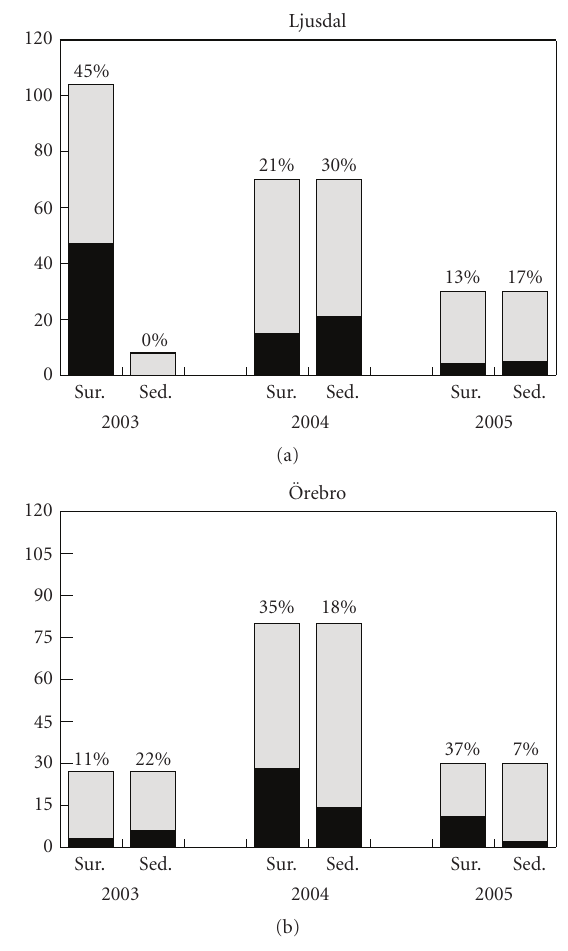
Figure 2: Stacked bar graph showing numbers of positive (black) and negative (light grey) samples during the sampling period (2003–2005) in Ljusdal (a) and ¨Orebro (b). The percentages of samples positive for F. tularensis are shown. (sur., water samples; sed., sediment